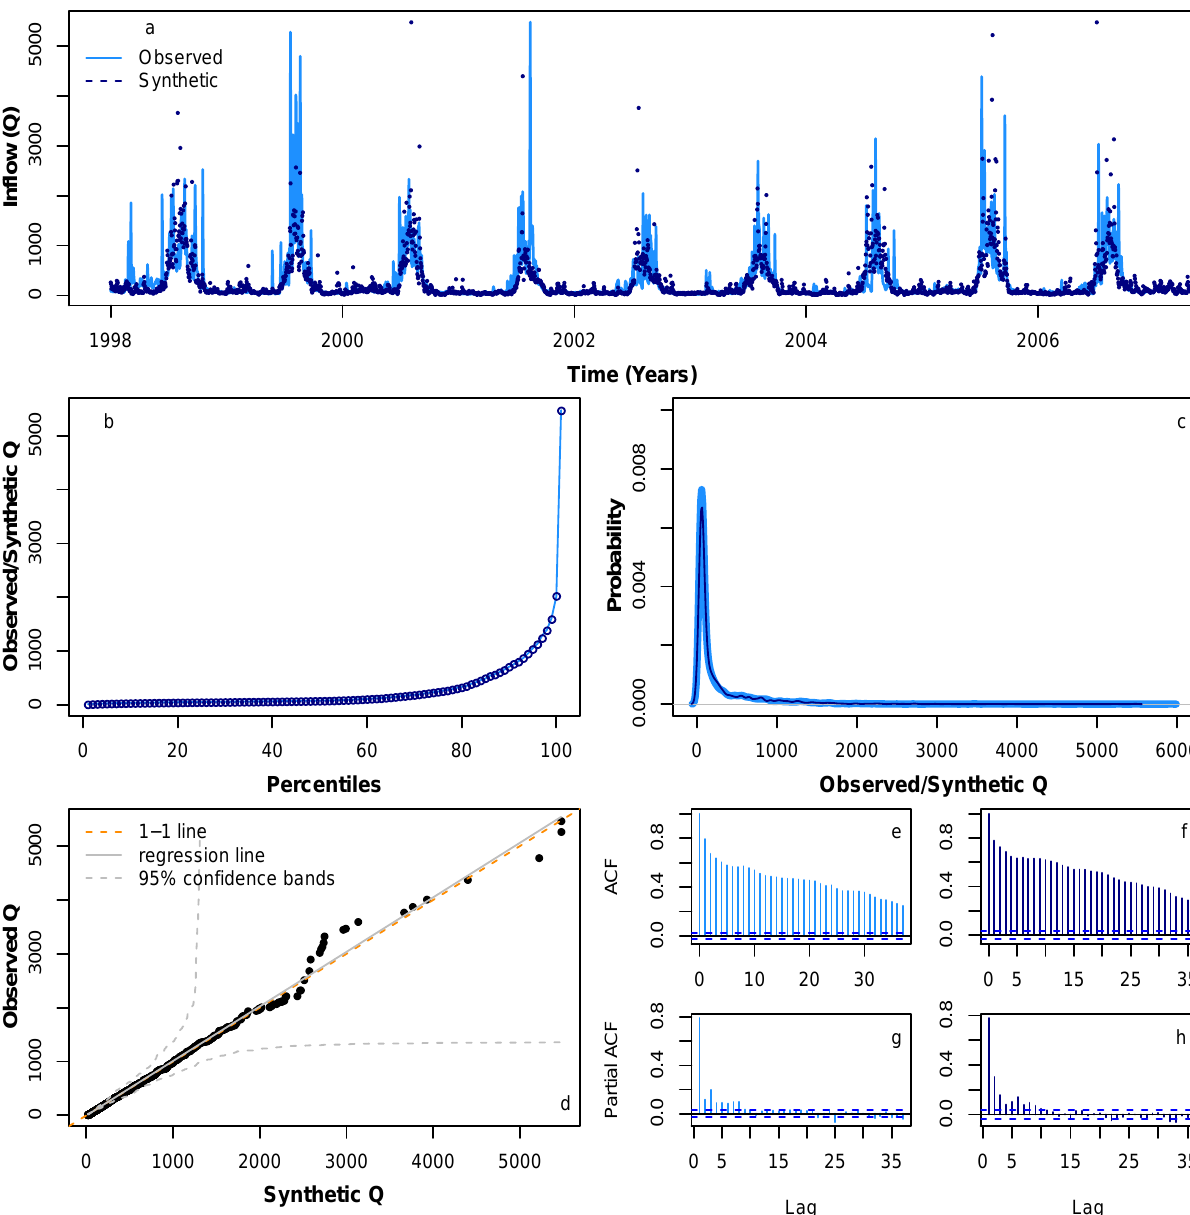
Figure 8. Comparison of various statistical characteristics of a sample synthetic Q time series during the period 1998–2006 (dotted navy lines), based on learning Q pattern from 1998 to 2006, with observed Q 1998–2006 time series (solid blue lines). Comparing ( a ) realisation; ( b ) percentiles; ( c ) probability density distribution; ( d ) QQ-plot; ( e ) ACF for observed; ( f ) ACF for a sample synthetic series; ( g ) PACF for observed; and ( h ) PACF for a sample synthetic